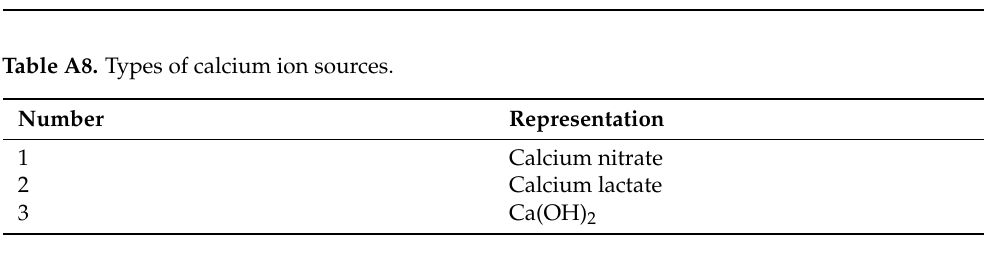
Table A9. Types of healing test